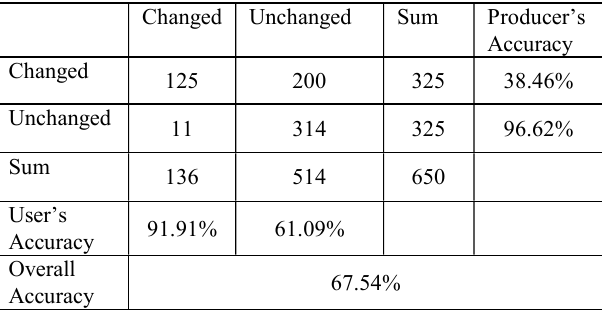
Table 7 Correctness rate of spurious change detection